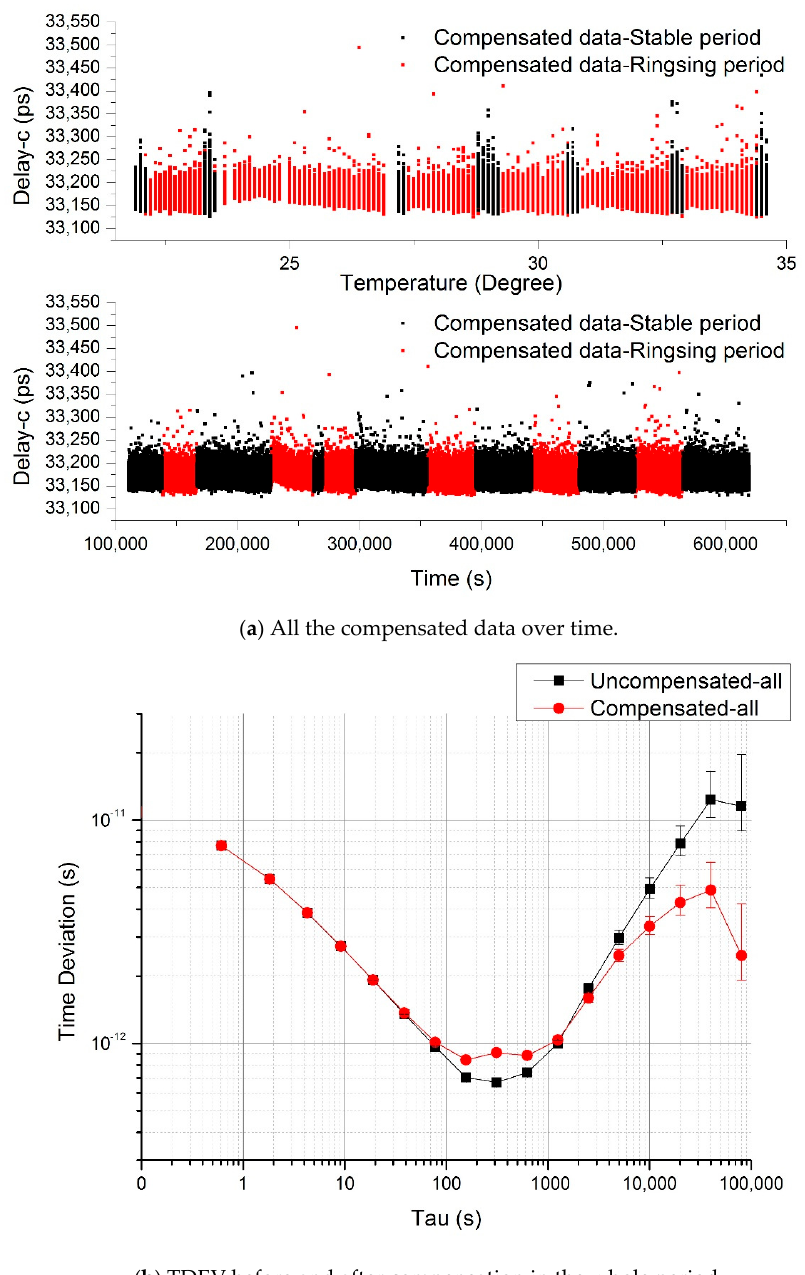
Figure 8. ( a ) All the compensated data over time. The upper graph is delay vs. temperature, and the lower graph is delay vs. time. ( b ) TDEV before and after compensation in the whole period. We also got the stabilities of the combined data with and without compensation as shown in Figure 8b. One can see from the TDEV diagram that the short-term stability gets worse in the averaging time between approximately 20 s and 1300 s; however, the long-term stability is much